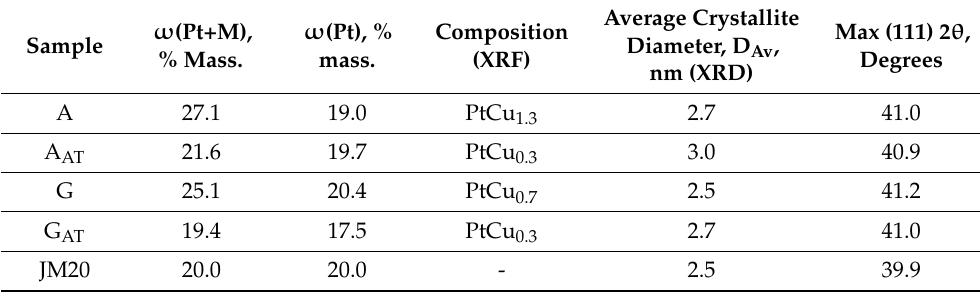
Table 1. The composition and structural parameters of the obtained PtCu/C catalysts and the commercial Pt/C